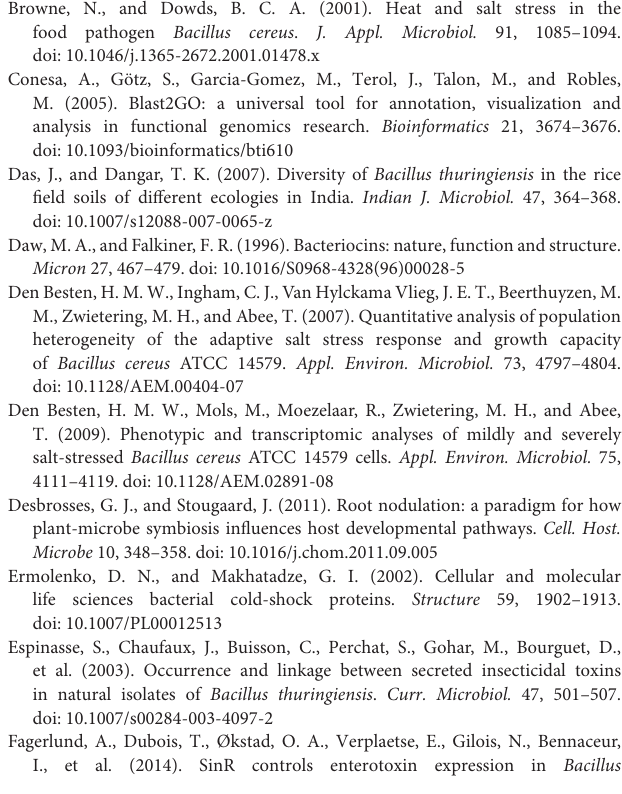
Supplementary Table 1 | Bacterial growth under salt stress data with statistical analysis. Supplementary Table 2 | Thuricin17 quantification under salt stress data with statistical